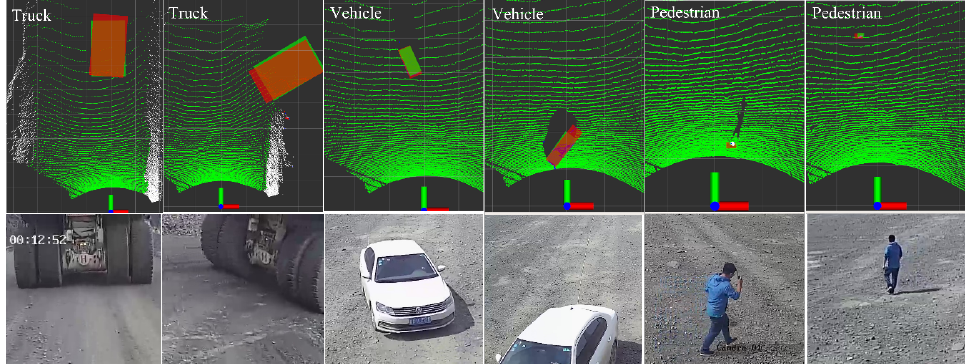
Figure 9. Qualitative analysis of TG-Mine-3D dataset. The first row shows BEV results. Ground truth boxes are shown in green, and detection results are in red. The second row shows the image corresponding to the first